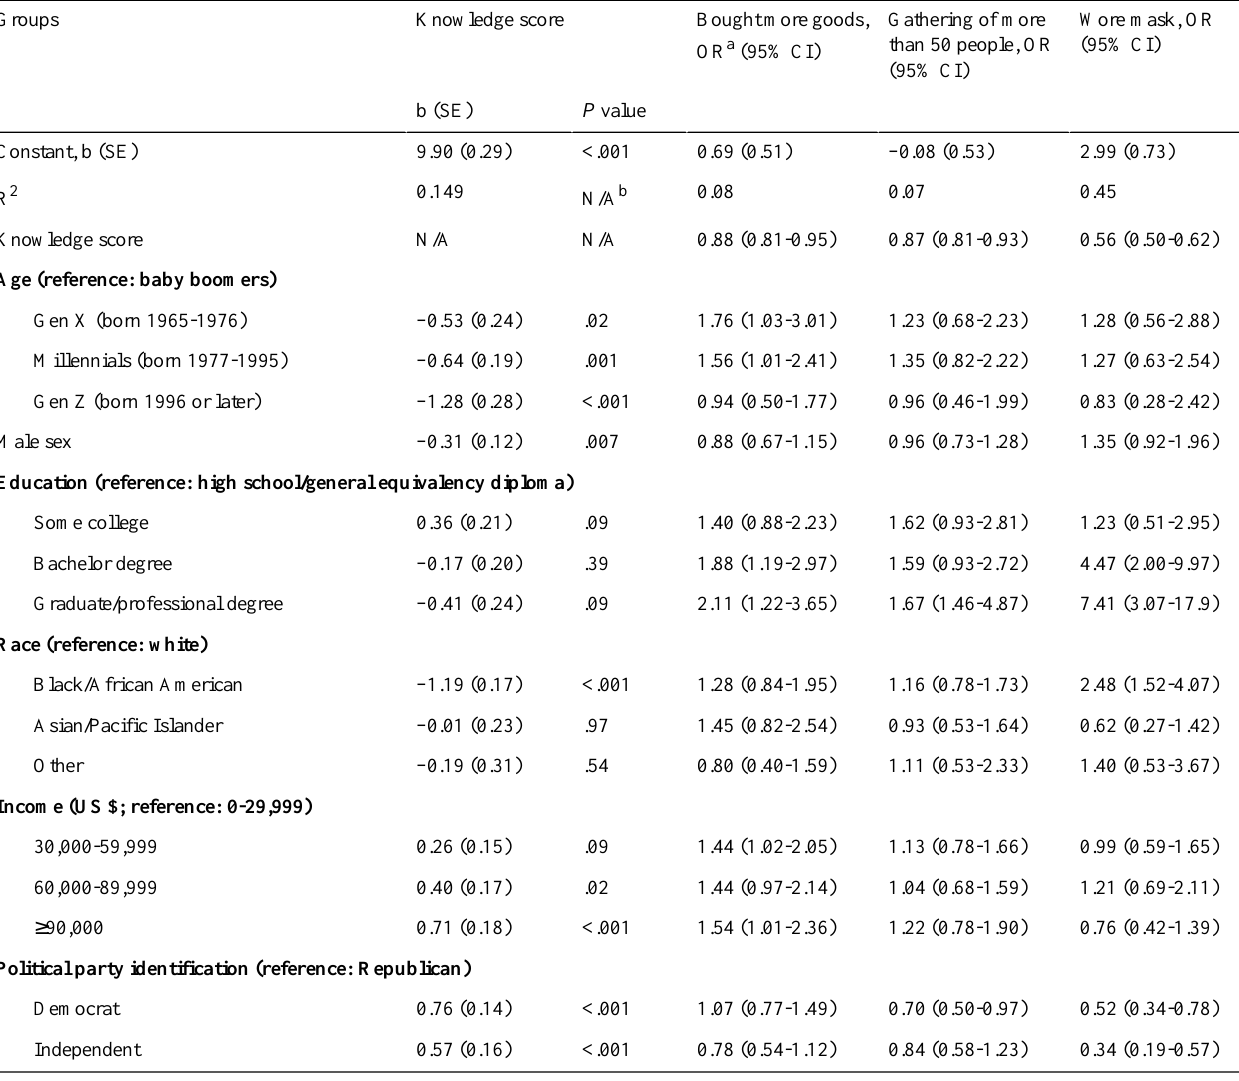
Table 3. Determinants of knowledge score and behavior outcomes of participants (N=1034).